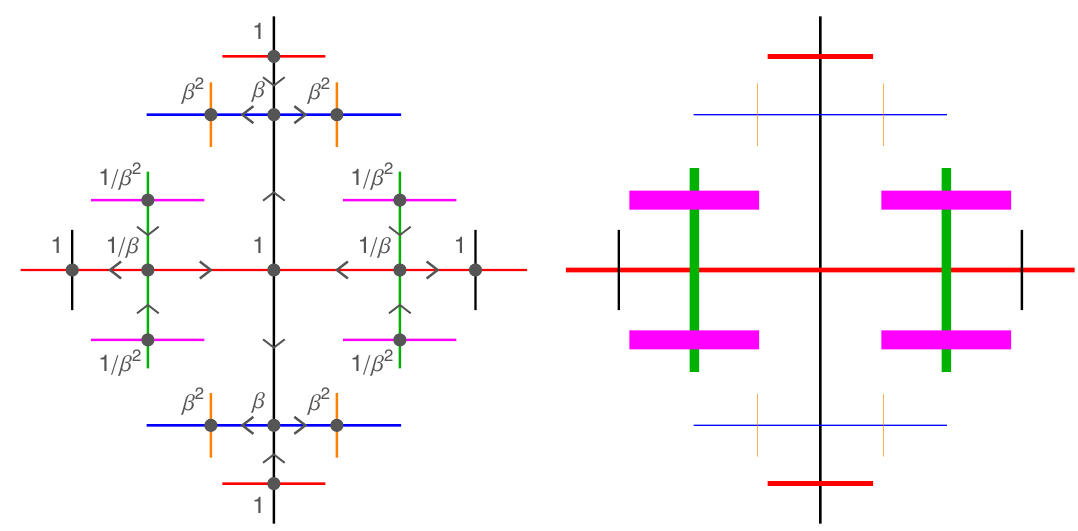
Figure 6 . A regular tree (for q = 3) with non-constant edge lengths as described by (5.11) and (5.13). Left: each vertex x is labeled by the value J x , and (cid:12) (cid:17) (~ (cid:27)=(cid:27) ) 2 . The orientation of an edge indicates the direction in which the edge can be expressed in the form w ! w j with j even. The color of the edge stands for the bond strength J xy . Edges of the same color have equal bond strengths. Right: the same tree, now with edges of larger width indicating larger bond strengths, taking (cid:12) <